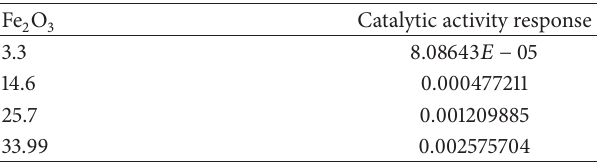
Table 3: Effect of Fe 2 O 3 .